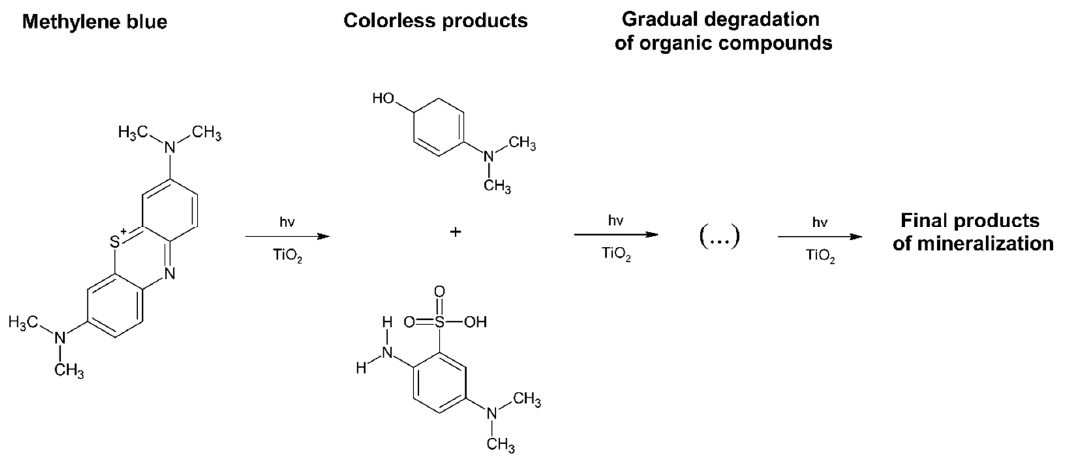
Figure 8. Simplified scheme of the methylene blue (MB) degradation by photocatalytic process on TiO 2 coatings under ultraviolet (UV) irradiation [27,28]. coatings under ultraviolet (UV) irradiation